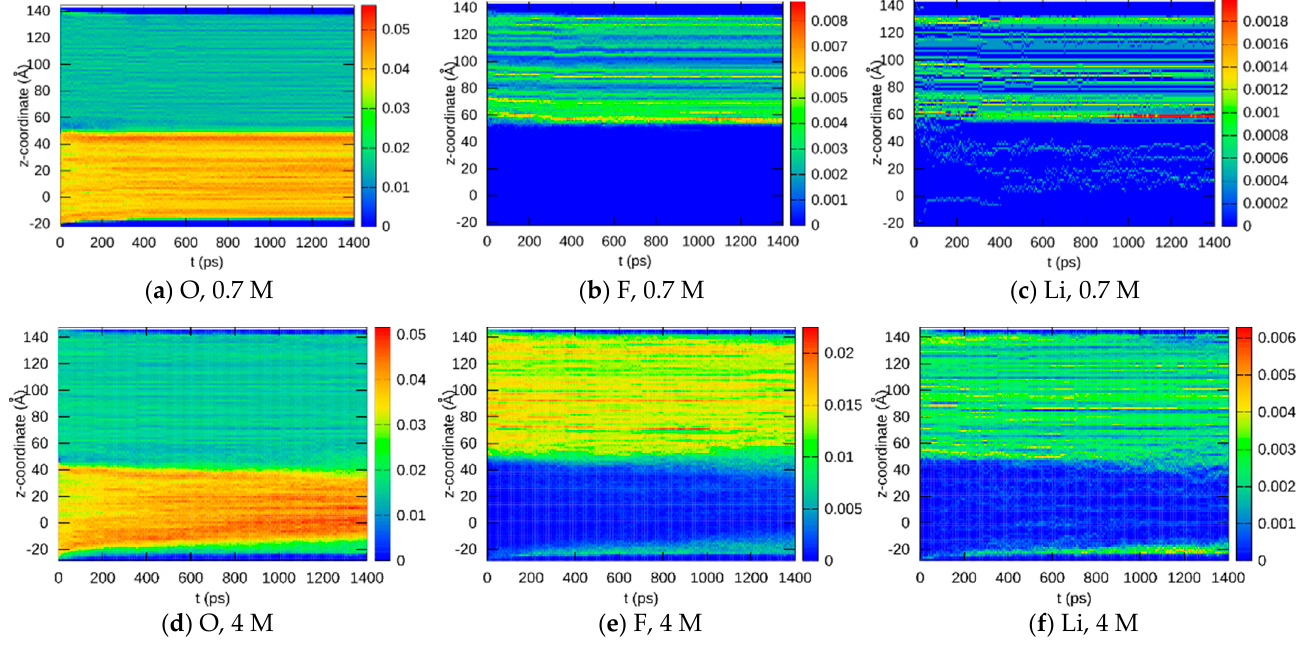
Figure 5. z -Coordinate and time-dependent element distributions for O ( a ), F ( b ), and Li ( c ) obtained from the ReaxFF MD trajectories at a 0.7 M LiTFSI and for O ( d ) F ( e ) and Li (f) at 4 M TFSI concen- trations.